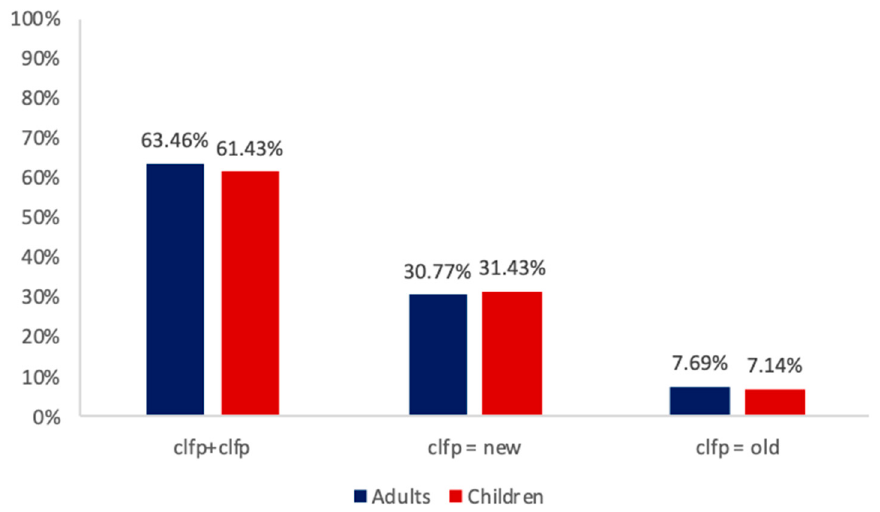
Figure 6. Mean proportions classifier NPs in conjunct NPs by IS in child and adult speech. (clfp = classifier phrase).